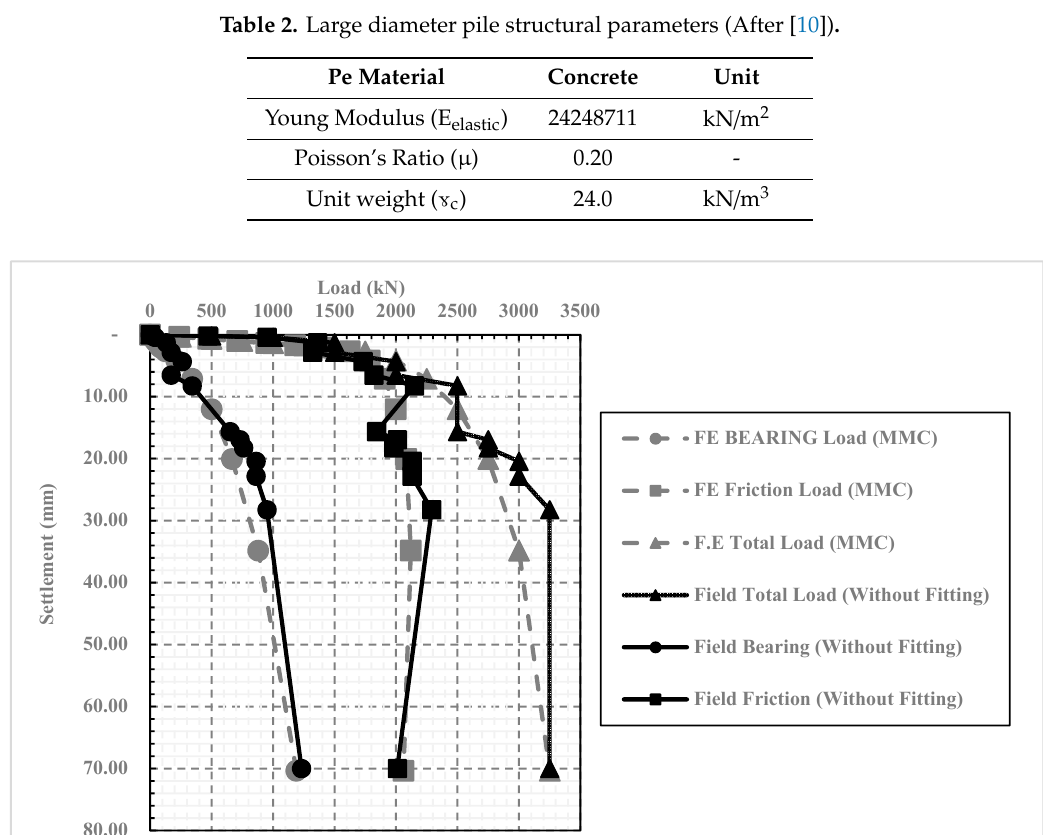
Figure 10. Comparison between field measurements and the obtained results of pile bearing, friction, the total load using the calibrated FE model [10].